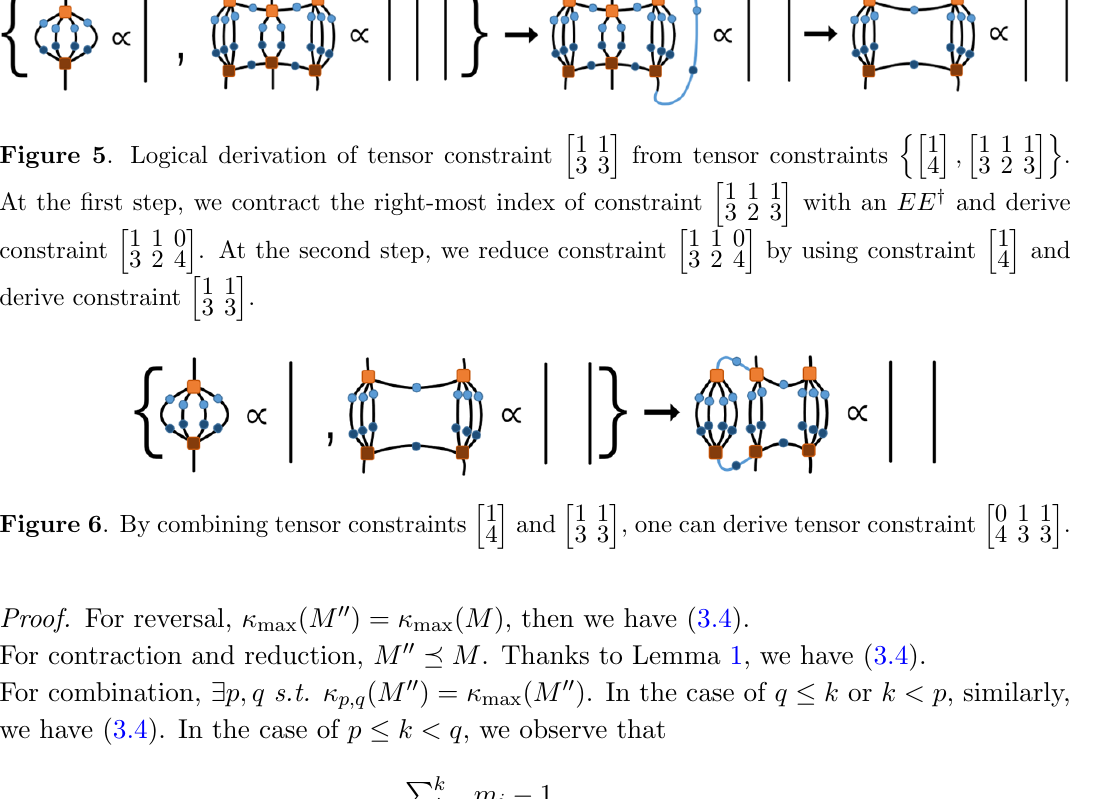
h 1 1 i nh 1 i h 1 1 1 io from tensor constraints ; . 3 3 4 3 2 3 h 1 1 1 i with an EE y and derive 3 2 3 h 1 1 0 i h 1 i by using constraint and 3 2 4 4